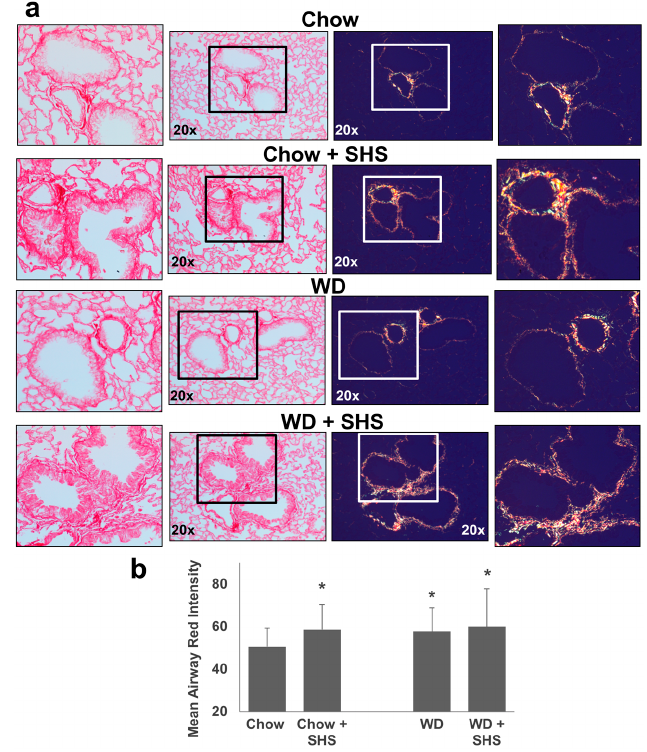
Figure 3. Collagen deposition in lungs of ApoE − / − mice fed rodent chow without (Chow) or with second hand smoke exposure (Chow + SHS) or fed Western Diet without (WD) or with smoke exposure (WD + SHS). Picro-sirius red stained lung tissue sections were viewed under regular light (left panels) or polarized light (right panels). Representative images are shown ( a ). Differences in intensity of red-orange birefringence from Picro-sirius red stained airways were evaluated using ImageJ software. Results were expressed as mean red component intensities ( b ). Groups exposed to SHS and/or WD scored significantly higher than the chow fed, air only group ( p < 0.05). Kruskal-Wallis ANOVA on ranks was used to assess statistical significance between groups ( p < 0.001) followed by post hoc testing with Dunn’s multiple comparison test for groups of interest, four to five mice per group were evaluated. * Significant difference